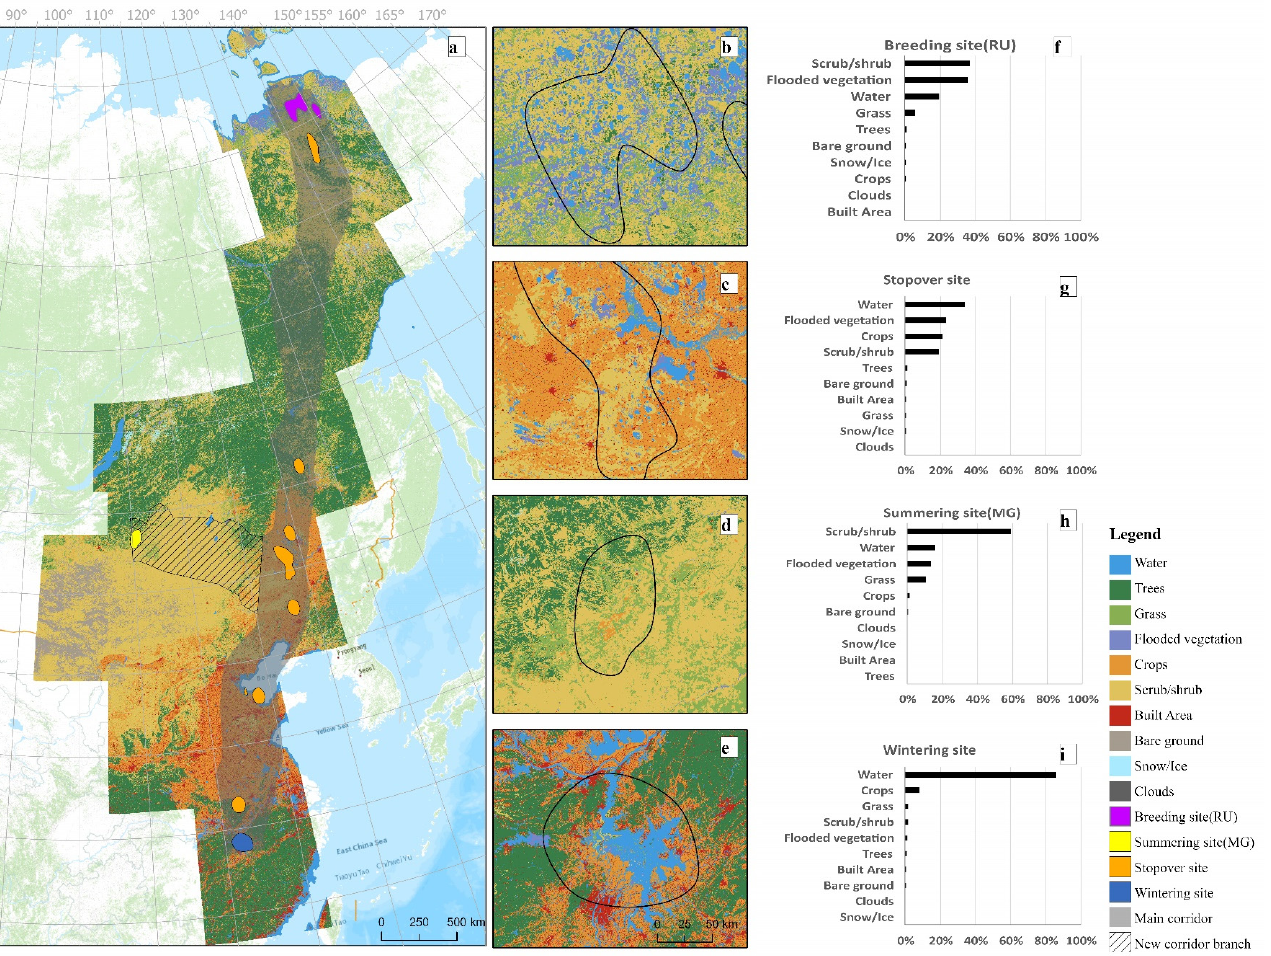
Figure 5. Mapping of the land cover traits of the Siberian crane ( Leucogeranus leucogeranus ) migration corridor. ( a ) Land cover maps of the migration corridor. ( b – e ) Land cover map of breeding in Russia, stopover, summering in Mongolia, and wintering extents, respectively. ( f – i ) Patterns of land cover used derived from the bird GPS fixes within the breeding, stopover, summering, and wintering extents, respectively. The scrub category mainly represents open areas covered in homogenous grasses with little to no tall vegetation in the study area, which was confirmed by our field